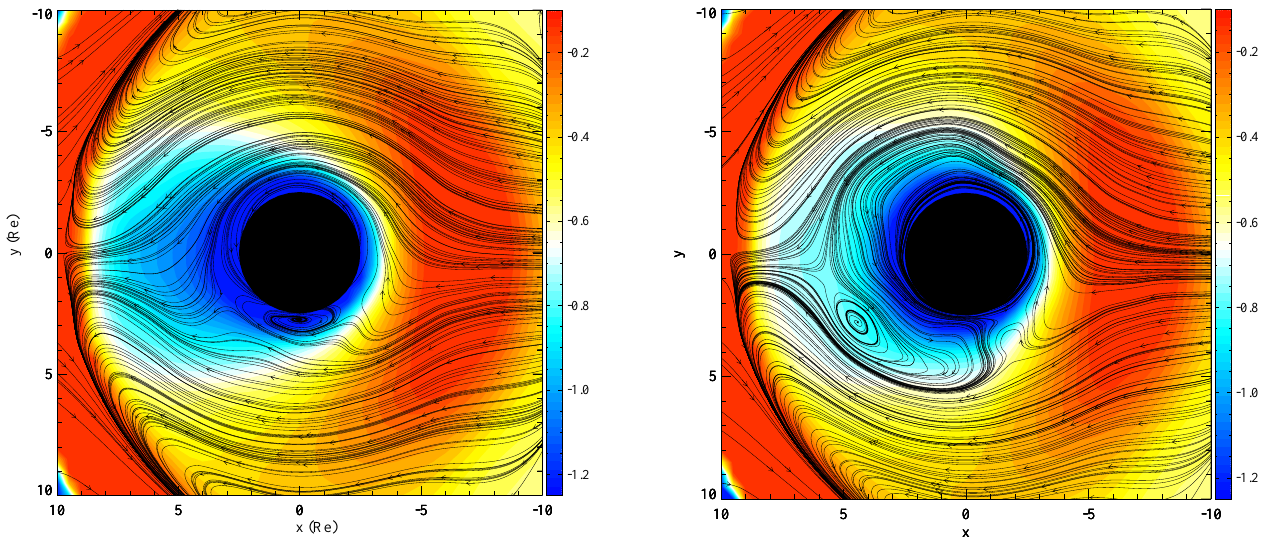
Plate 5. Flowlines in the magnetosphere in the X − Y plane, neglecting U z , over color contours of log (p) , where the pressure is in nP. The top plot shows a simulation in which the Pedersen conductance was uniform at 1mho (i.e. Plate 1A and B, Plate 1C and D), while the bottom plot shows a solar maximum simulation in which only the solar EUV was considered, corresponding to Plate 4E–H. The density of the streamlines does not correspond to the strength of the